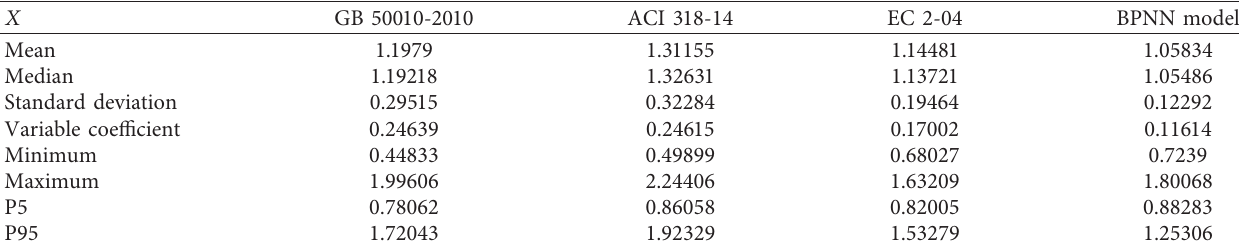
Table 3: Statistical eigenvalue.